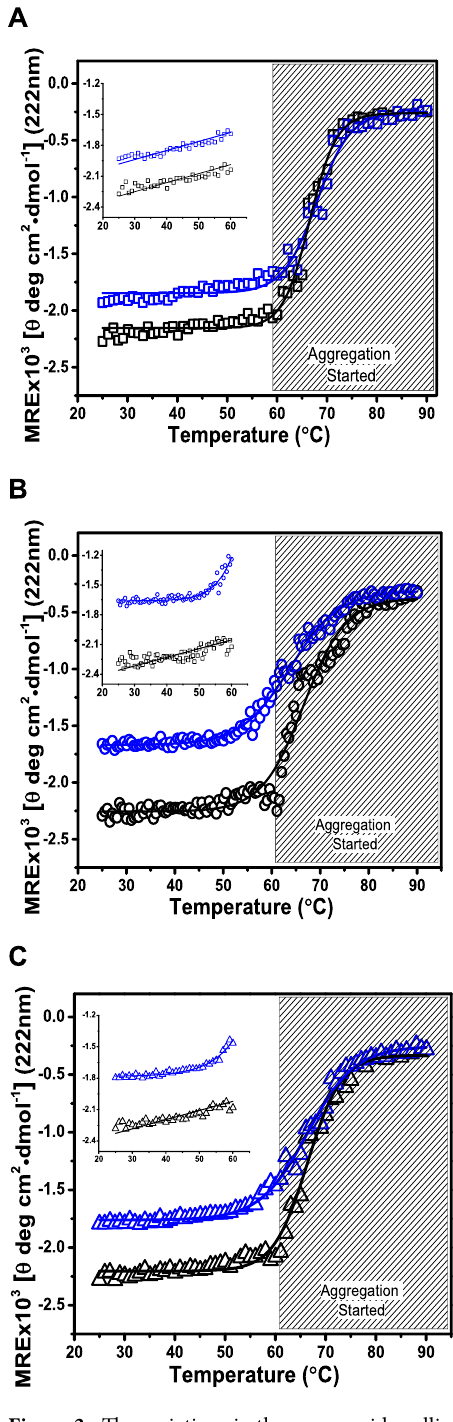
Figure 3. The variations in the mean residue ellipticity (MRE) values at 222 nm in variable temperature CD experiments are plotted here (blue and black squares represent data from gelsolin samples, 0.5 and 1 mg/ml, respectively). The gray shaded zone indicates samples at which whitish aggregation was visible. ( A ) Buffer having 1 mM free Ca 2 + ions and pH of 8, ( B ) buffer lacking any free Ca 2 + ions and pH 5, and ( C ) buffer lacking any free Ca 2 + ions, and pH